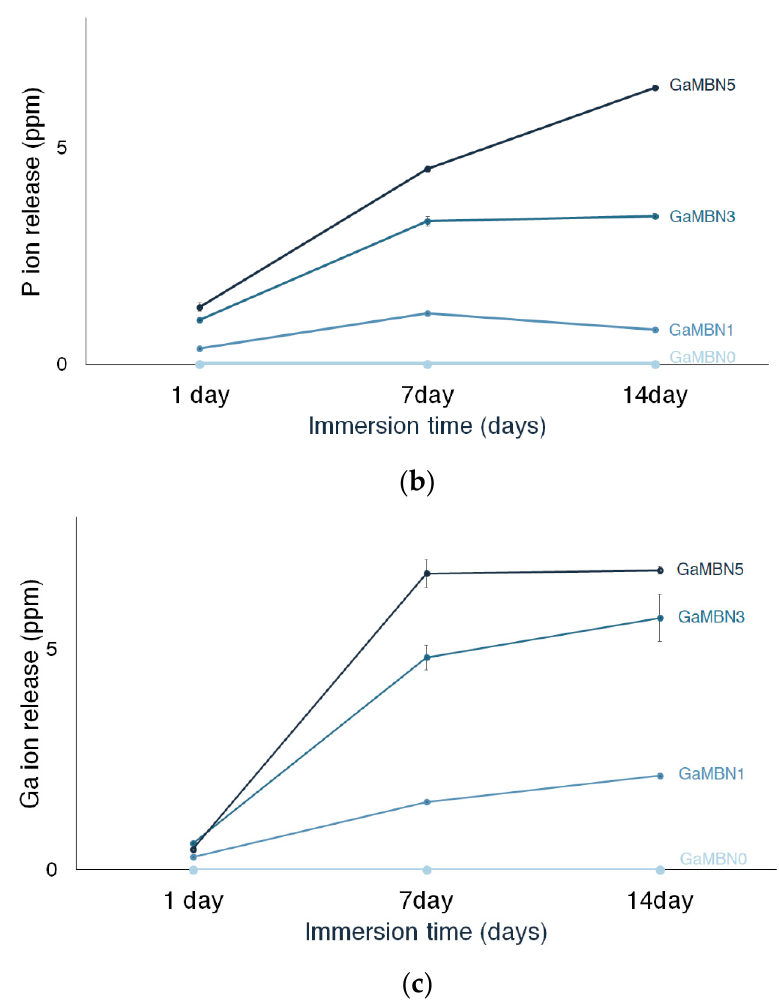
Figure 6. Concentration of ( a ) Ca, ( b ) P, and ( c ) Ga ions released by the GaMBN resin disks as determined by ICP-OES (Inductively Coupled Plasma Optical Emission Spectrometry) analysis.